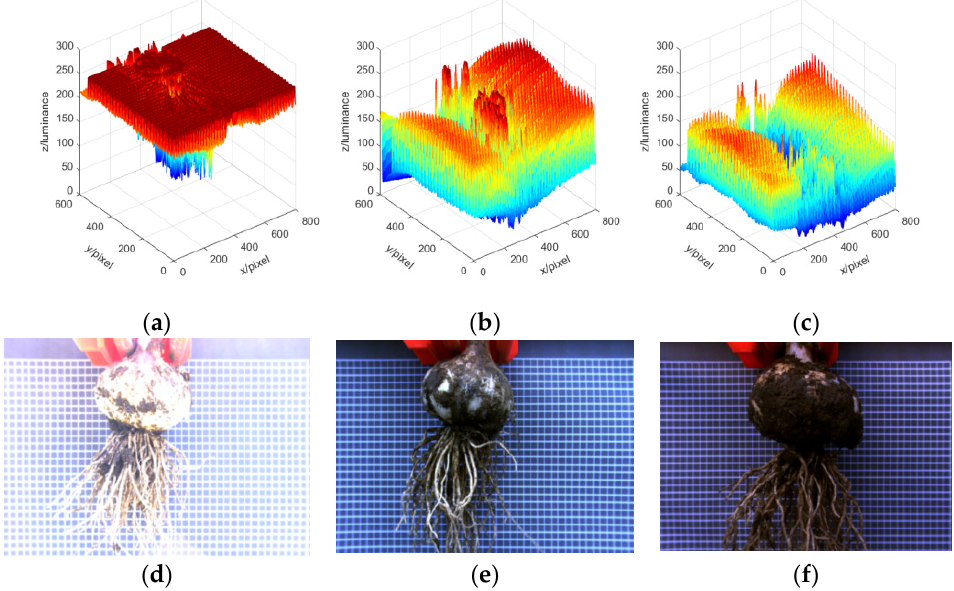
Figure 6. Diagram of brightness level differences: ( a ) corresponds to ( d ), ( b ) corresponds to ( e ), ( c ) corresponds to ( f ); ( d ) the average value of Y is 224.4; ( e ) the average value of Y is 100.5; and ( f ) the average value of Y is